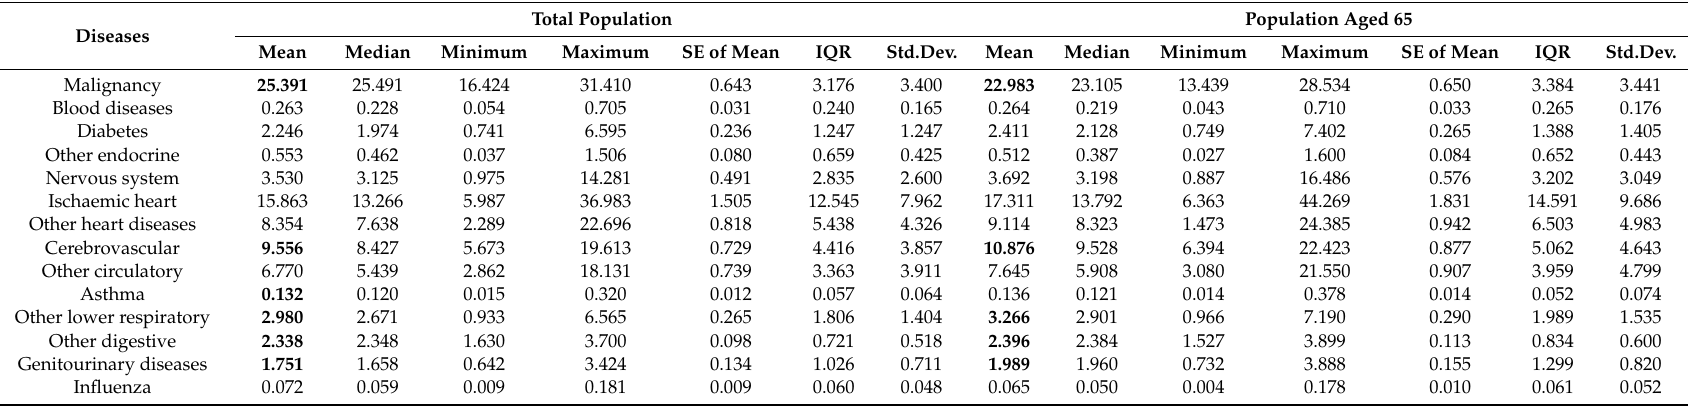
Table 2. Descriptive statistics of COVID-19 comorbidities shares of death for 28 countries in the European Union—an average of 2011–2016 (percentages).